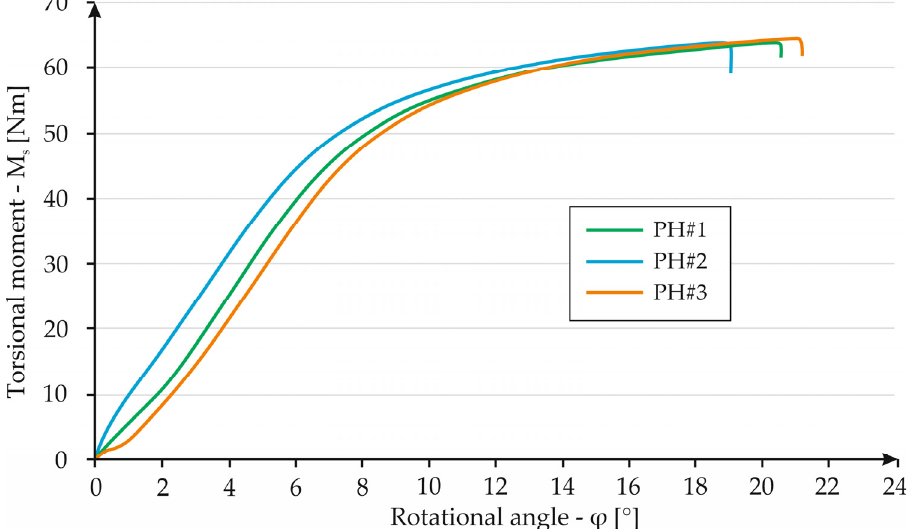
Figure 17. Graph showing the dependence of torque on torsion angle for HS specimens.